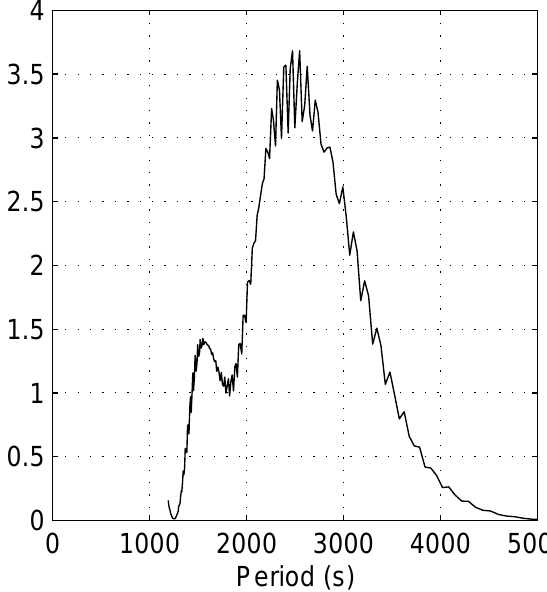
Fig. 10. Lomb-Scargle periodogram of the altitudes of maximal full-projection correlations for the image series of 9 January 1997. The abscissae are an interval of angular frequencies converted to periods.